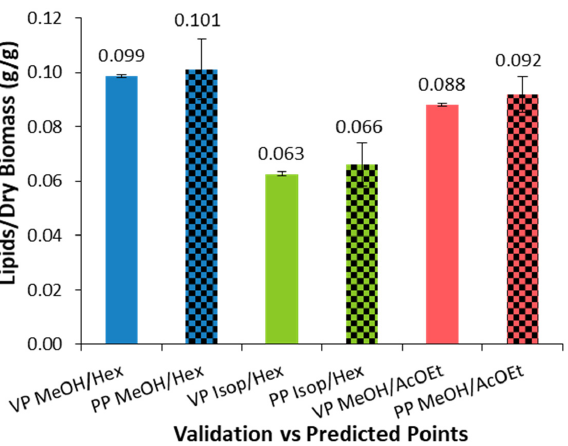
points. In particular, the percent convergence for MeOH/Hex was 97.7%, for Isop/Hex 95.0%, and for MeOH/AcOEt 95.8%.